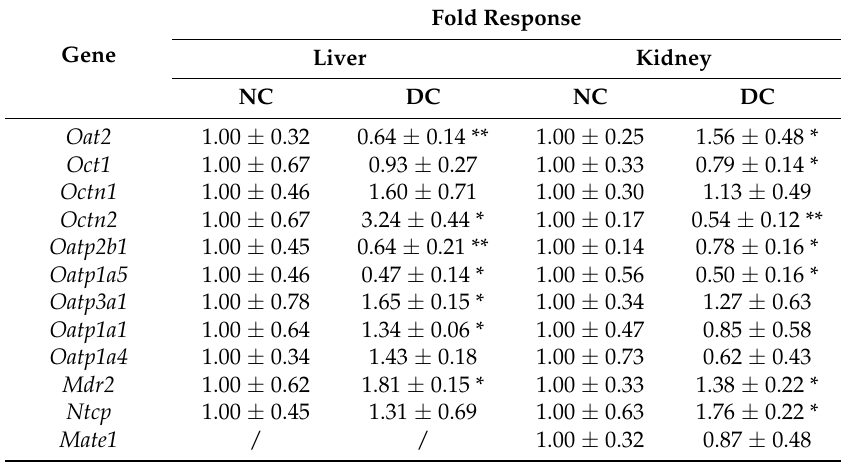
Table 2. The mRNA expression of transporters in liver and kidney in diabetic rats ( n = 6).